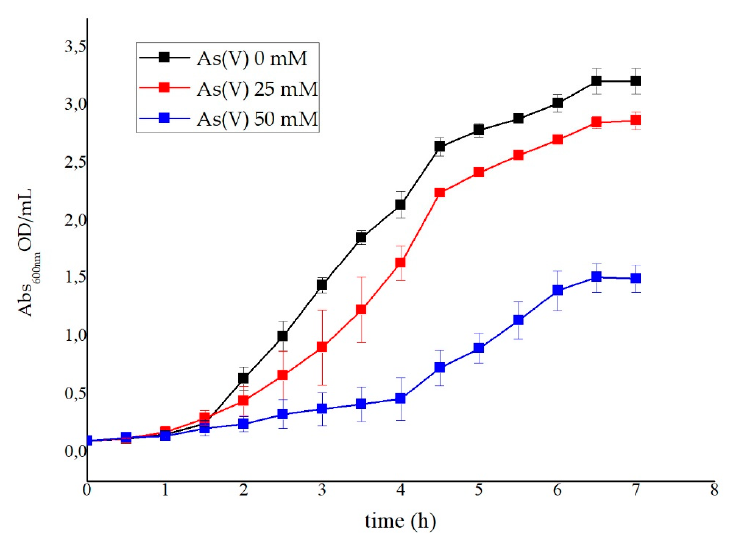
Figure 3. G. stearothermophilus GF16 grown in the presence and absence of As(V).